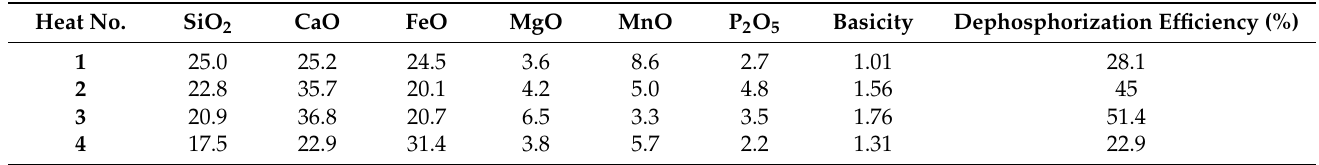
Table 3. Slag composition and dephosphorization